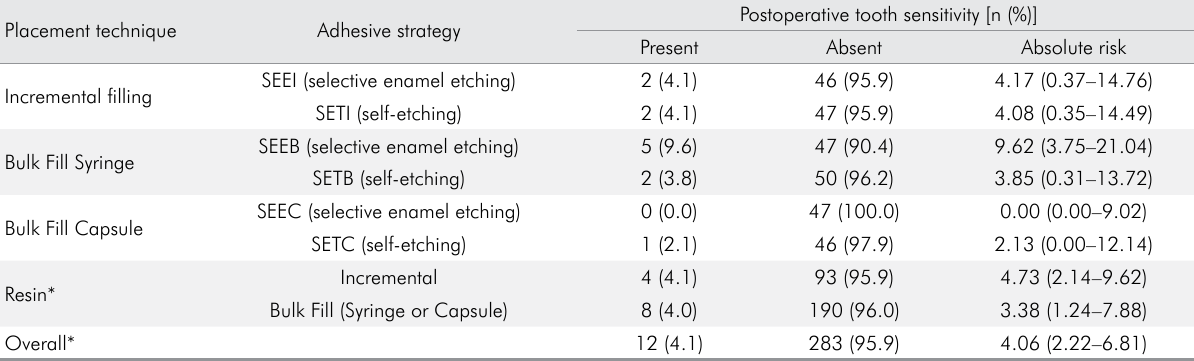
Table 4. Frequency distribution of spontaneous postoperative sensitivity occurrence (regardless of time and scale of assessment) after restorative procedures in the experimental groups.